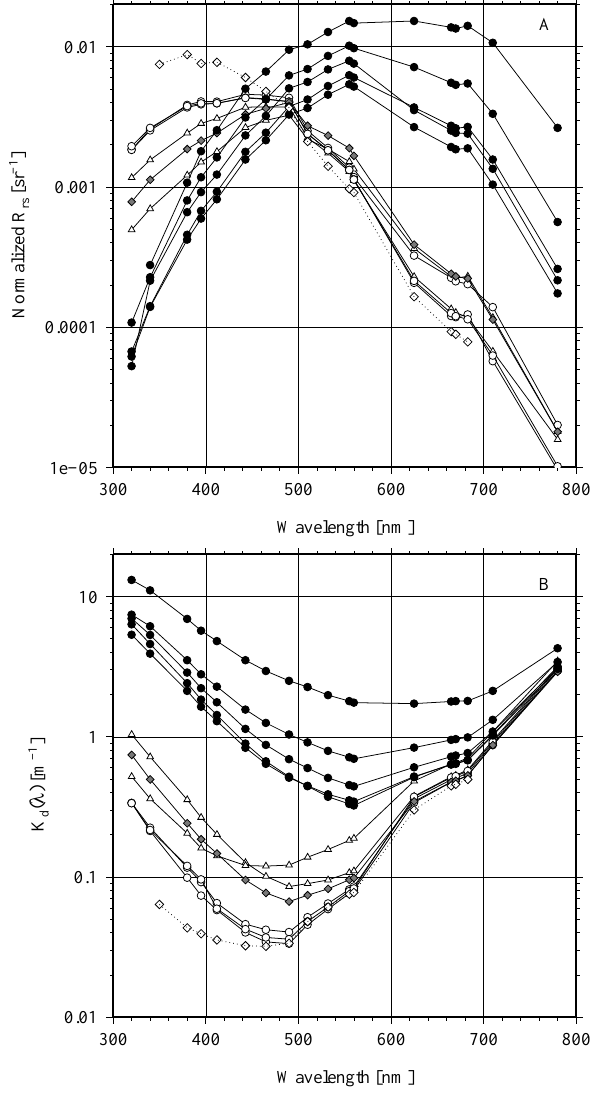
Fig. 6. Example R rs (A) and K d (B) spectra, for stations 320, 340 and 360 (open waters), 235 and 460 (ice edge), 380 (coastal), and 394–398 (eastern Mackenzie transect). The open diamonds show modeled values from Morel and Maritorena